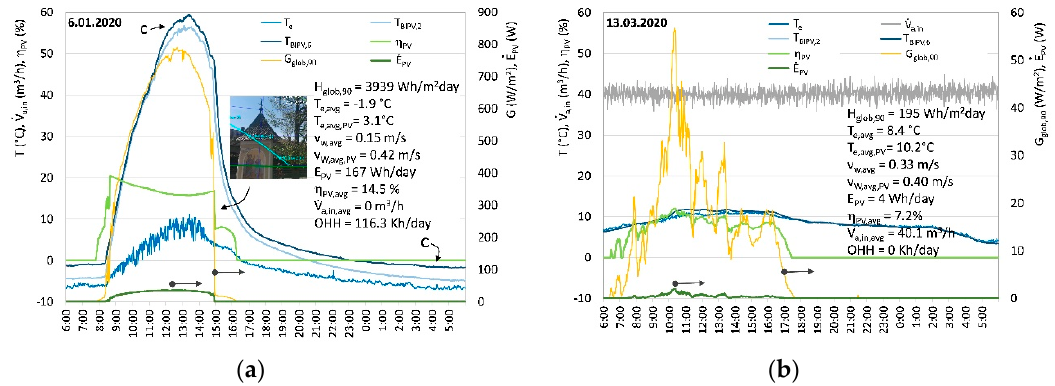
Figure 5. Graphs showing instant η PV and average diurnal PV cell e ffi ciency η PV,avg , instant . E PV , and diurnal production of electricity E PV ( a ), PV cell temperatures (glass electricity power surface temperatures behind PV cell towards ventilated air gap) in the 2nd ( T BIPV,2 ) and the 6th row ( T BIPV,6 ) in BIPV, overheating hours ( OHH) and selected meteorological data—solar irradiation G glob,90 , diurnal solar radiation H glob,90 , and instant and daily average outdoor air temperature ( T e , T e,avg ) ( b